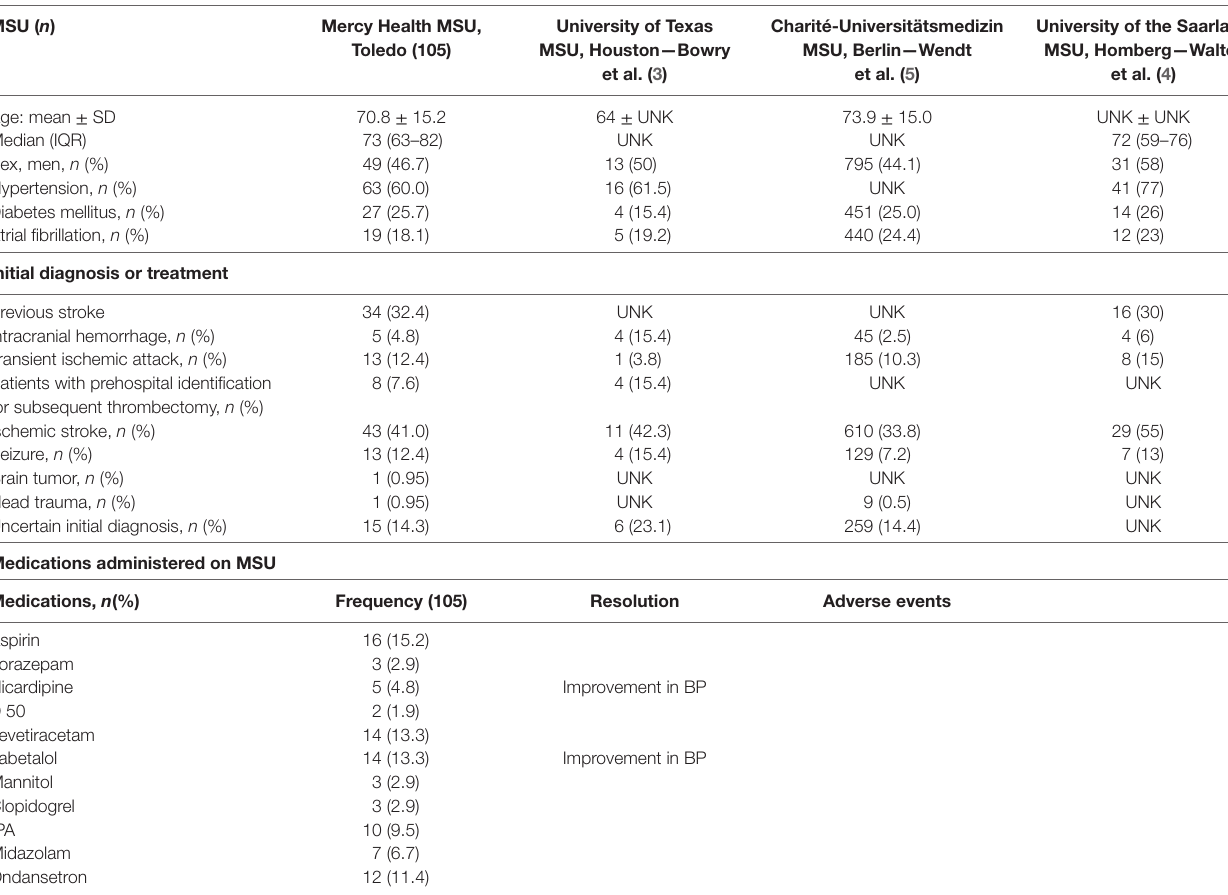
TaBle 1 | Demographics, initial diagnoses, and treatment of Mercy Health Mobile Stroke Unit (MSU) patients vs. other MSUs. MsU ( n ) Mercy health MsU, Toledo